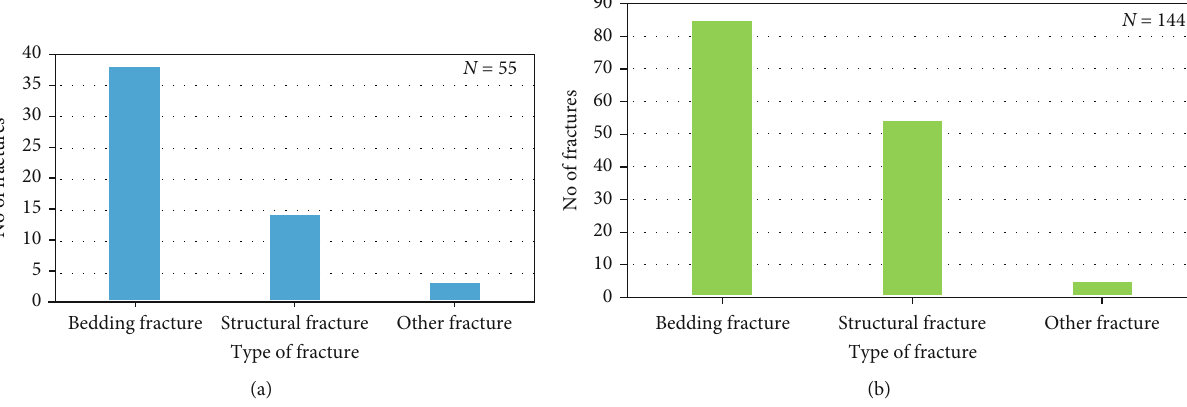
Figure 11: (a) Statistical chart of number of oil-immersed fractures in cores from Lucaogou formation in Jimsar sag; (b) statistical chart of number of oil-spotted fractures in cores from Lucaogou formation in Jimsar